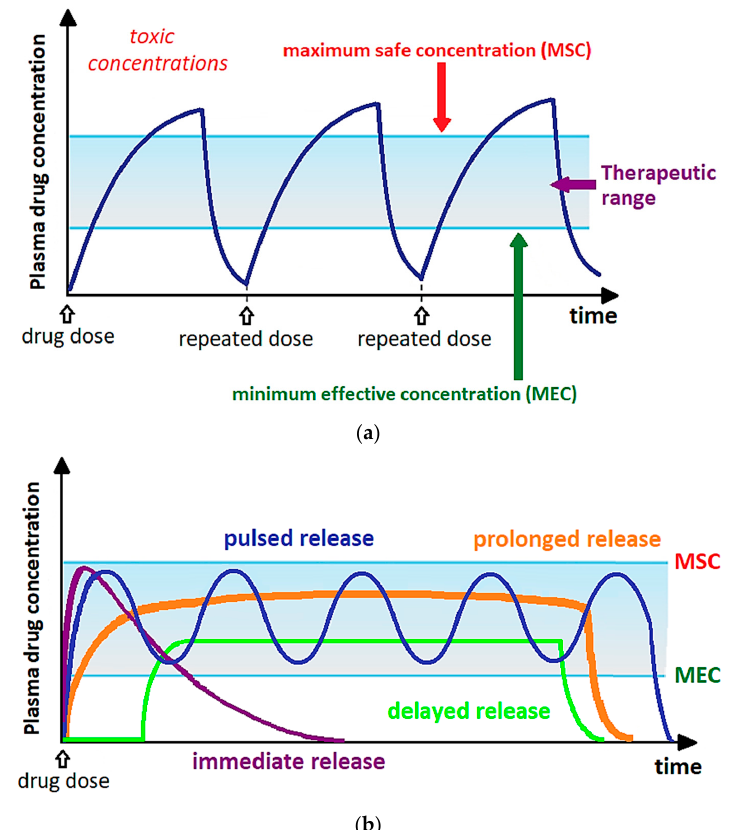
Figure 1. ( a ) Conventional pharmaceutical formulations; ( b ) modified-release drug delivery systems.